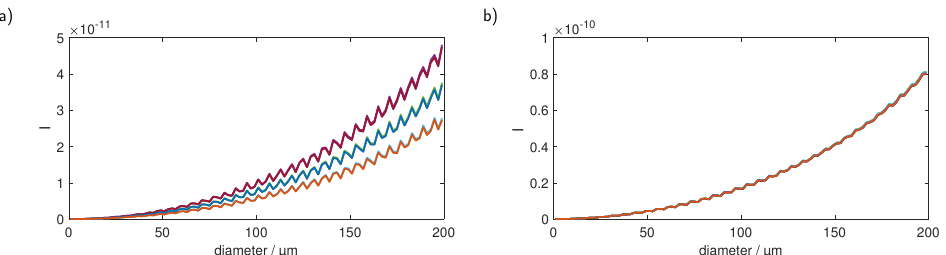
Figure 5. MC simulation of fiber detectors at ( a ) 45 ◦ and ( b ) ≈ 70 ◦ . The latter angle is obtained due to the refraction of the light that was originally originating at 45 ◦ from the scatterer. Each color represents a different particle